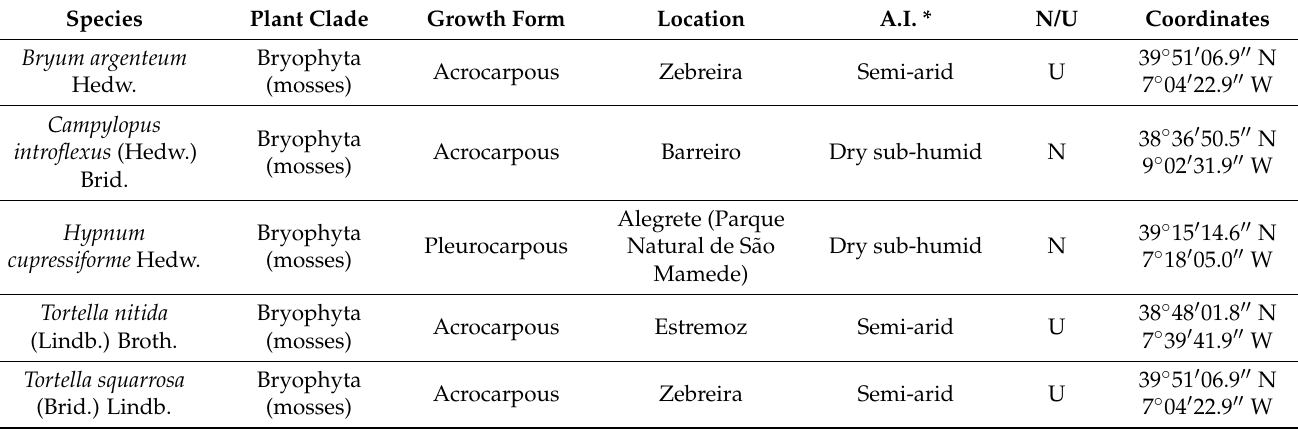
Table 2. Bryophyte species collected in the present study (clade, growth form, location, aridity index (1980–2010) (A.I.), natural (N), or urban (U) site, coordinates). Species Plant Clade Growth Form Location A.I. * N/U Coordinates Bryum